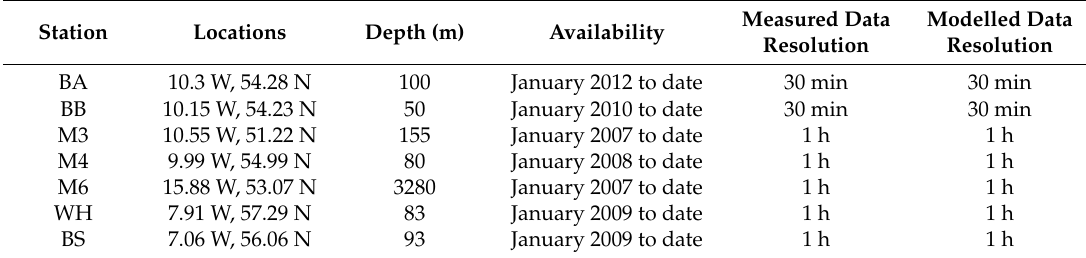
Table 1. Summary of available measured wave data. BA: Berth A; BB: Berth B; WH: West-hebrides; and BS: